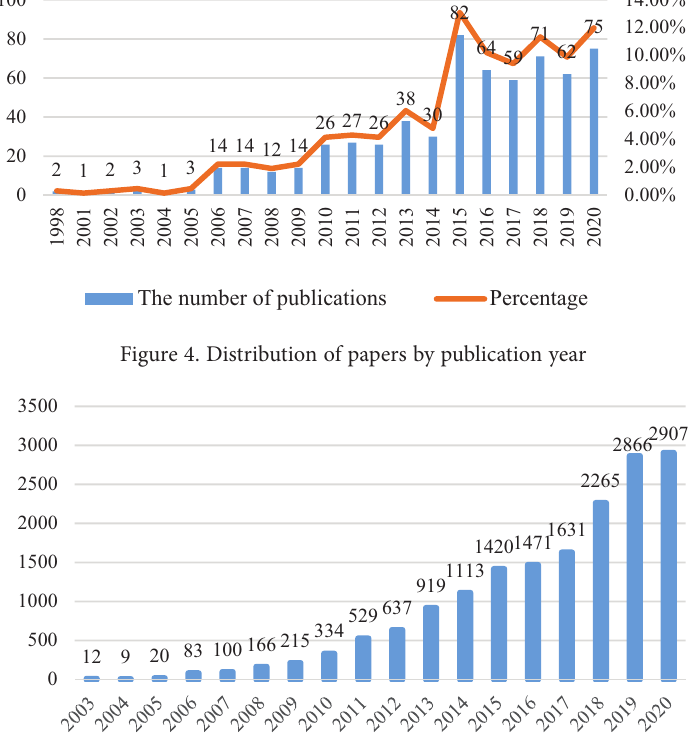
Figure 5. Distribution of citation times per